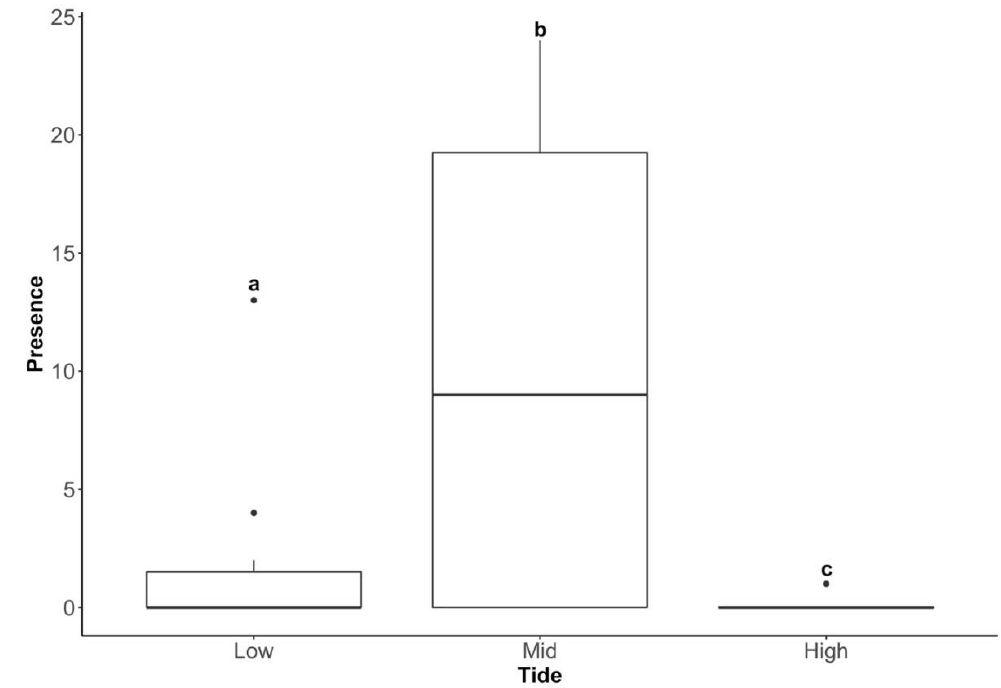
Figure 6. Air temperature, average wind speed, as well as air and substrate R.H. across the three tidal zones (low, mid and high). Means with the same letter are not significantly different at p < 0.05 (Pairwise Wilcoxon Rank Sum Tests).